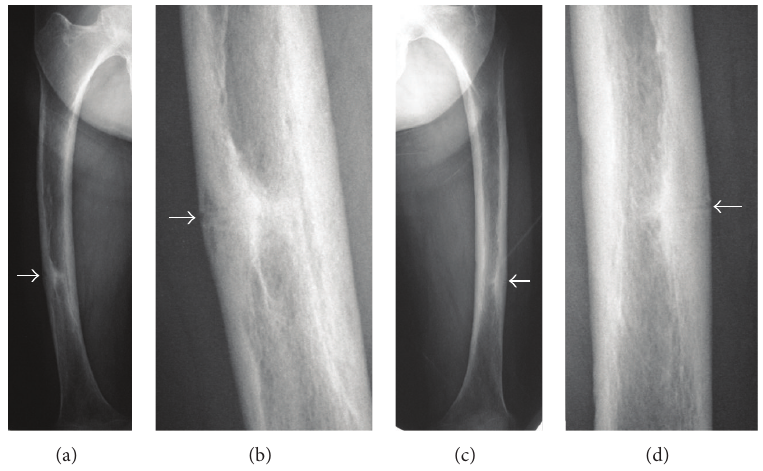
Figure 4: Anteroposterior radiographs of the bilateral femurs ((a) right femur; (c) left femur). (b) and (d) are magnified views of (a) and (c), respectively. They showed thickening of the outer cortex and a horizontal line resembling a